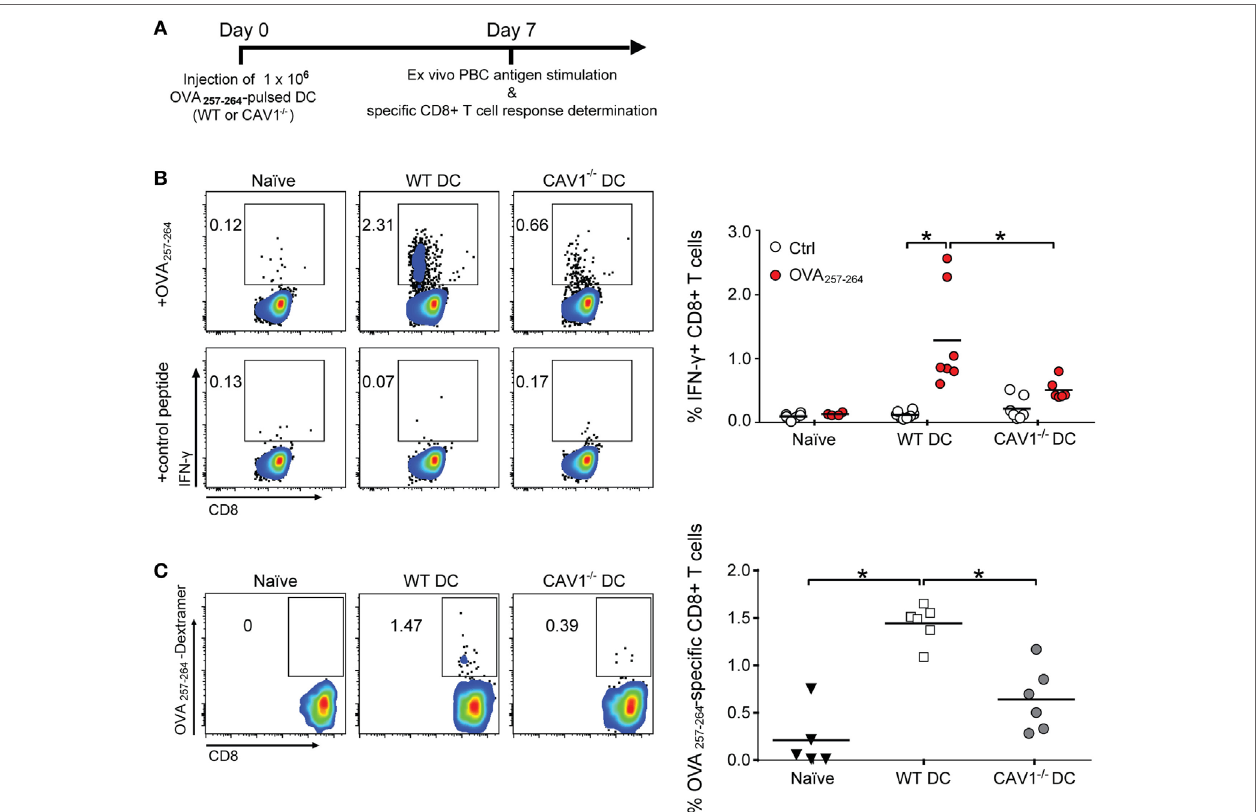
FigUre 4 | Caveolin-1 (CAV1) promotes the ability of dendritic cells (DCs) to induce antigen-specific CD8 + T cell responses. (a) Scheme of the experimental procedure. At day 0, 1 × 10 6 OVA 257–265 -pulsed wild-type (WT) or CAV1 − / − bone marrow-derived DCs (BM-DCs) were transferred to recipient WT mice. After 7 days, blood samples were taken, and CD8 + T cell responses were analyzed. (B) Cells were stimulated with control (trp2 180–188 ) or OVA 257–265 peptides for 2 h, and then brefeldin A-containing solution (Golgi plug) was added for another 6 h (8 h total stimulation). Afterward, cells were stained and analyzed by flow cytometry. Representative dot plots of IFN- γ expression on gated CD3 ++ CD8 + T cell population and the percentage of IFN- γ -producing CD8 + T cells are shown. Bars are the mean ± SEM (* p < 0.05, n = 7 mice, from two independent experiments). (c) Freshly isolated cells were stained with H-2 Kb/SIINFEKL (OVA 257–265 peptide) dextramer to determine antigen-specific CD8 + T cells. Representative density plots and quantification of frequency of dextramer-positive from totalCD3 + CD8 + T cell population are shown. Data are the mean ± SEM (* p < 0.05, n = 5–6 mice from two independent